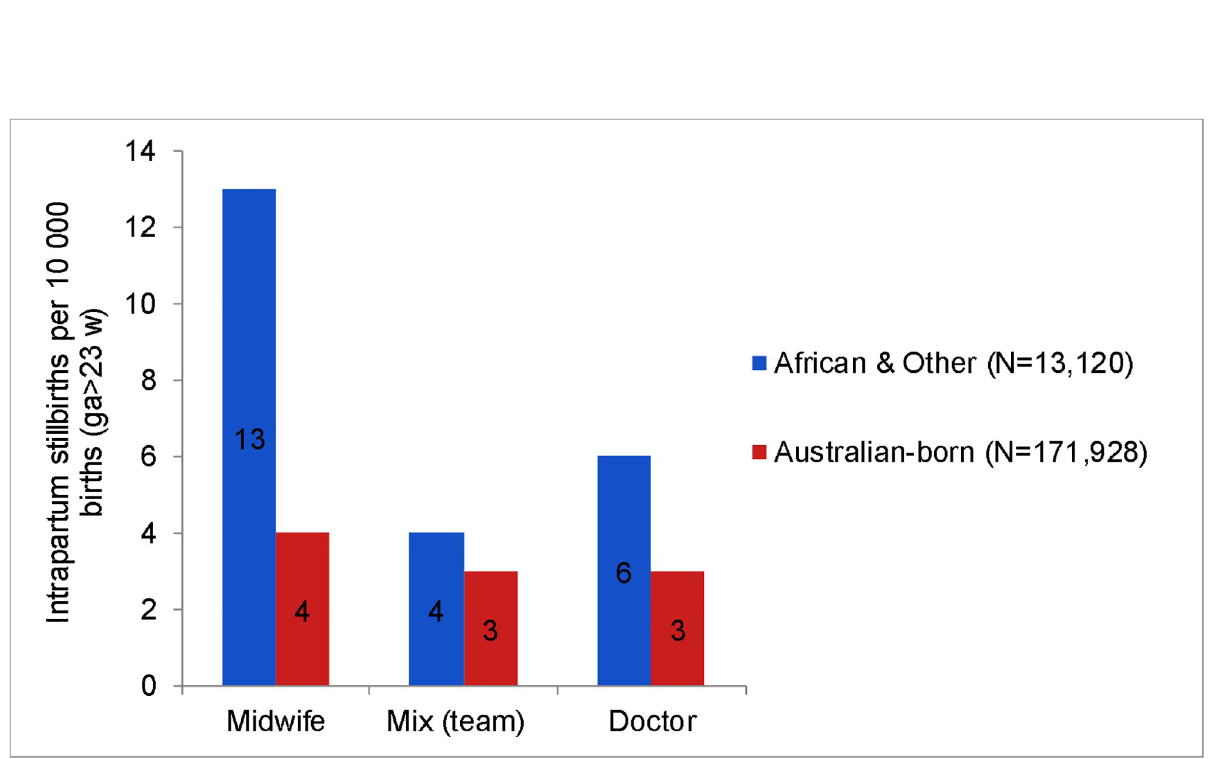
Fig 3. Unadjusted cumulative incidence rate of intraSB ( > 23 weeks gestation) by intrapartum care provider (2005–2013). Note: Doctor Birth attendant/supervisor indicates that birth was attended by an obstetrician and/or by other medical practitioners, whereas Mix (team) attendant/ supervisor refers to occasions when both doctor and midwife were present at birth. intraSB, intrapartum